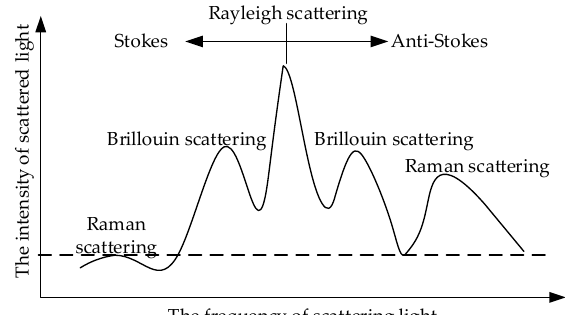
Figure 1. Scattering in optical fibre.